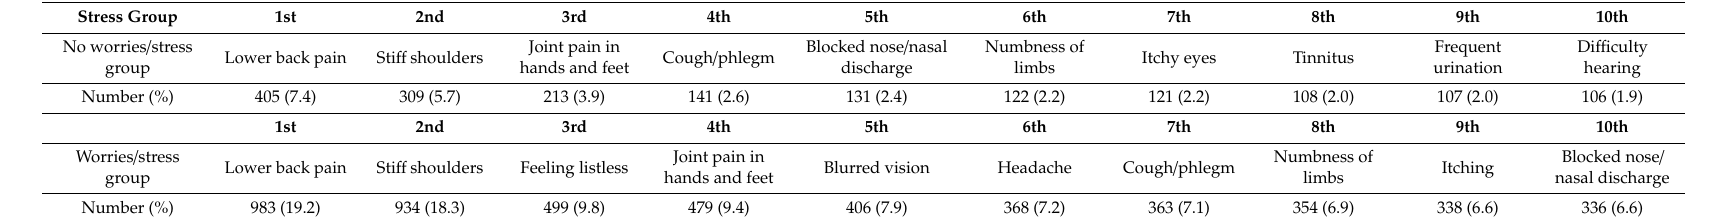
Table 3. Symptoms with highest frequency of response by stress group (top 10 ranked).